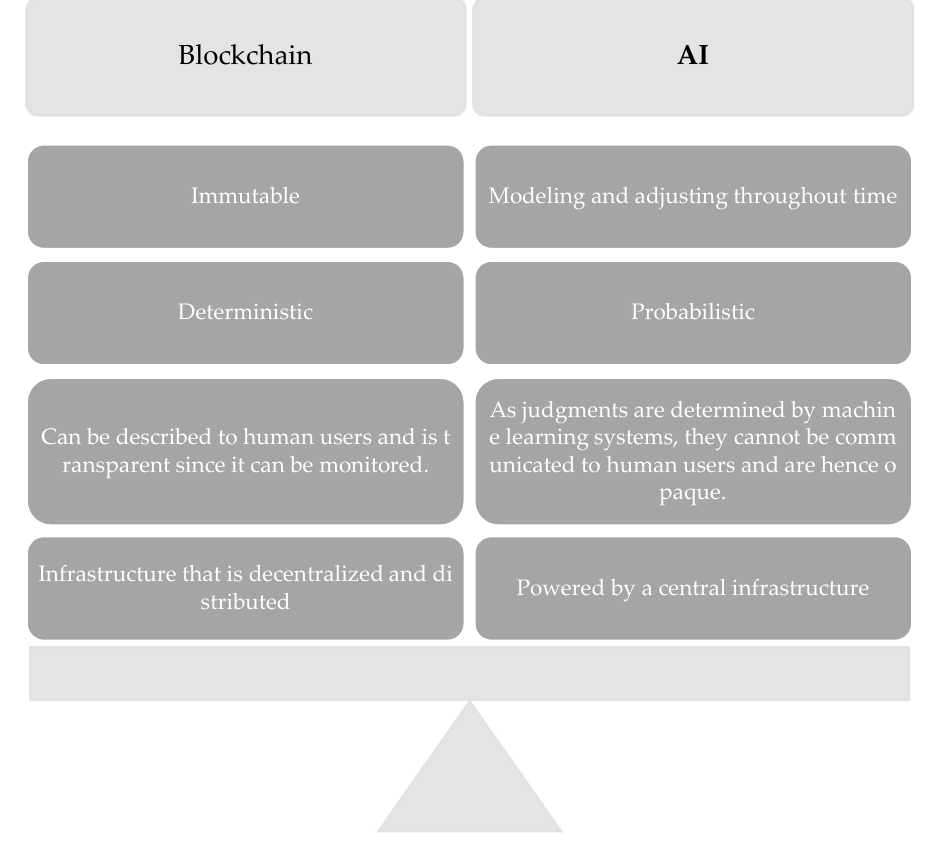
Figure 1. Properties of AI and blockchain.